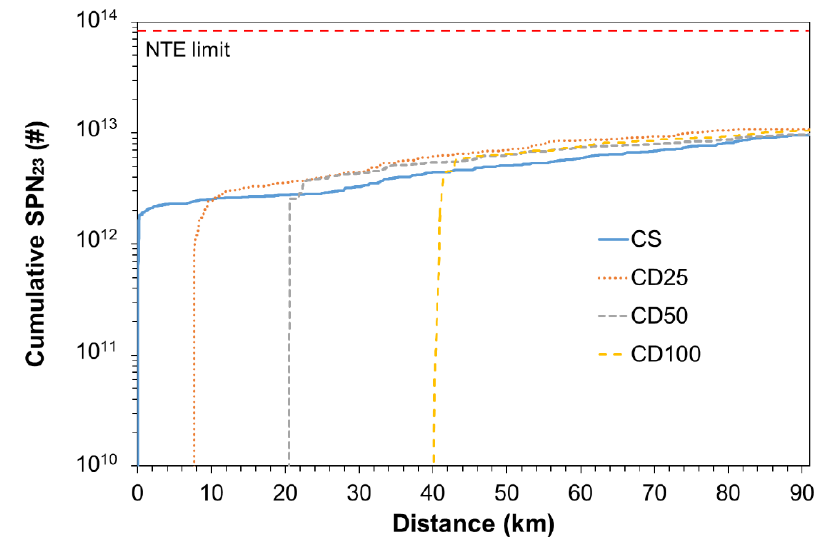
Figure 5. Cumulative SPN 23 emissions of V2 over distance, tested on-road according to the European real driving emissions regulation (RDE). CDx denotes the charge of the REESS; CD100 for 100%, CD50 for 50%, CD25 for 25%. CS stands for trips in charge-sustaining or discharged REESS. The red dashed line shows the Euro 6 on-road not-to-exceed (NTE) limit multiplied with the distance driven.